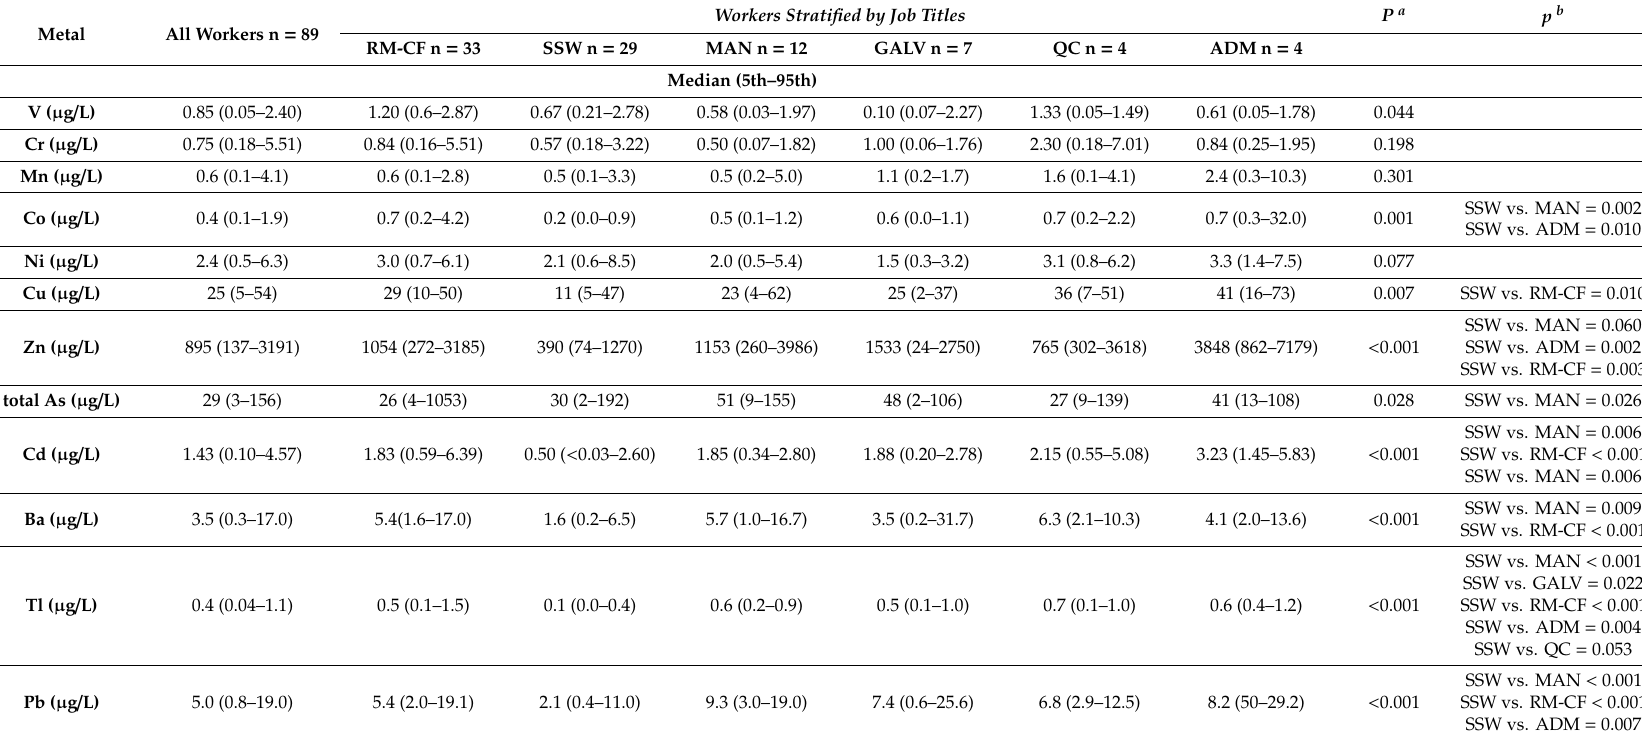
Table 1. Urinary metal levels in all study subjects and in subjects stratified by job titles. Median (5 th -95 th ) is shown for each metal. The results of the statistical comparison among job title is also